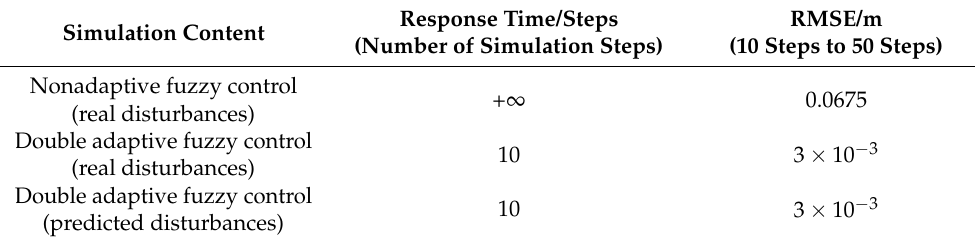
Table 9. Comparison of firefighting operation performance of different control methods ([6] and this